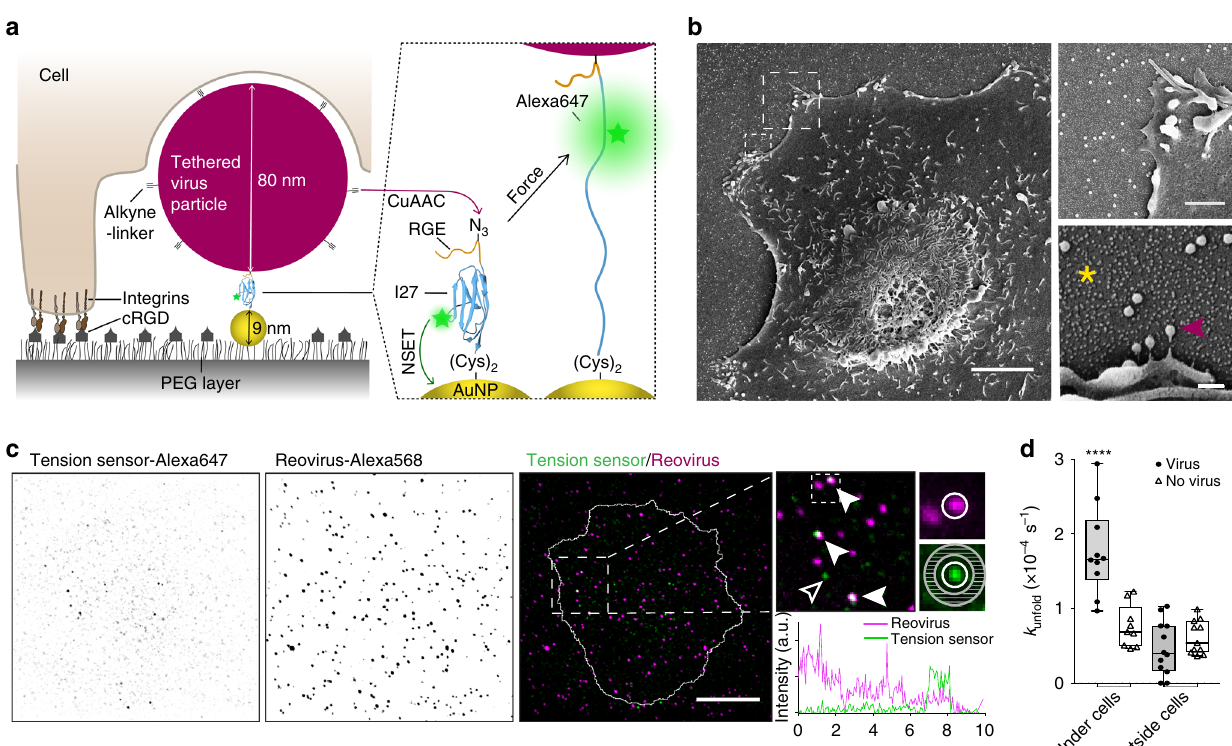
Fig. 1 Molecular tension sensors detect forces on virus particles exerted by the ventral cell side. a Schematic of a cell interacting with a tethered virus particle from its ventral side (not to scale). PEG-passivated glass coverslips were decorated with cRGD ligands (gray) for integrin-speci fi c cell adhesion and tension sensors consisting of gold nanoparticles (AuNPs, yellow) and Alexa647-labeled titin I27 domain (blue). Alkyne-modi fi ed reoviruses (magenta) were tethered via click chemistry (CuAAC). Fluorescence of the tension probes is quenched by the AuNP via nanometal surface energy transfer (NSET) and increases upon unfolding. b SEM images of a BSC1 cell on an array of tension sensors (asterisk) onto which single virus particles are bound (arrowhead). Scale bars, 5 μ m (overview), 1 μ m (upper), 200 nm (lower panel). c Maximum projections of TIRF images over 10 min of titin-based tension sensors (green) and fl uorescently labeled reoviruses (magenta) and merge with the cell outline (see Supplementary Movie 1). Arrowheads indicate signals of opened tension sensors at virus sites. Hollow arrowhead points towards a nonspeci fi c tension signal. Scale bar, 10 μ m. Fluorescence intensity traces were analyzed at sites of viruses (white circle) or at random spots not co-localizing with viruses after subtraction of the local background signal (gray annulus). Reovirus signal decays over time due to photobleaching of the sparsely Alexa568-labeled virus. d Rate k unfold of tension sensors with characteristic increase in fl uorescence representing the tension sensor unfolding at sites of virus immobilization/at random spots under the cells and in a control region outside of cells during 10 min, 1 h post seeding cells ( n = 10, 11, 12, 13 cells or control regions, with a total number of 114 events out of 1073 virus particles, 88 non-speci fi c events out of 2549 random spots underneath the cells, 40 events per 1228 viruses and 80 non-speci fi c events out of 2713 random spots in the control region, respectively, three technical replicates, box-plots represent median ± 95% CI with whiskers to the min and max values, **** P < 0.0001, one-way ANOVA with post hoc Tukey). Source data are provided as a source data fi